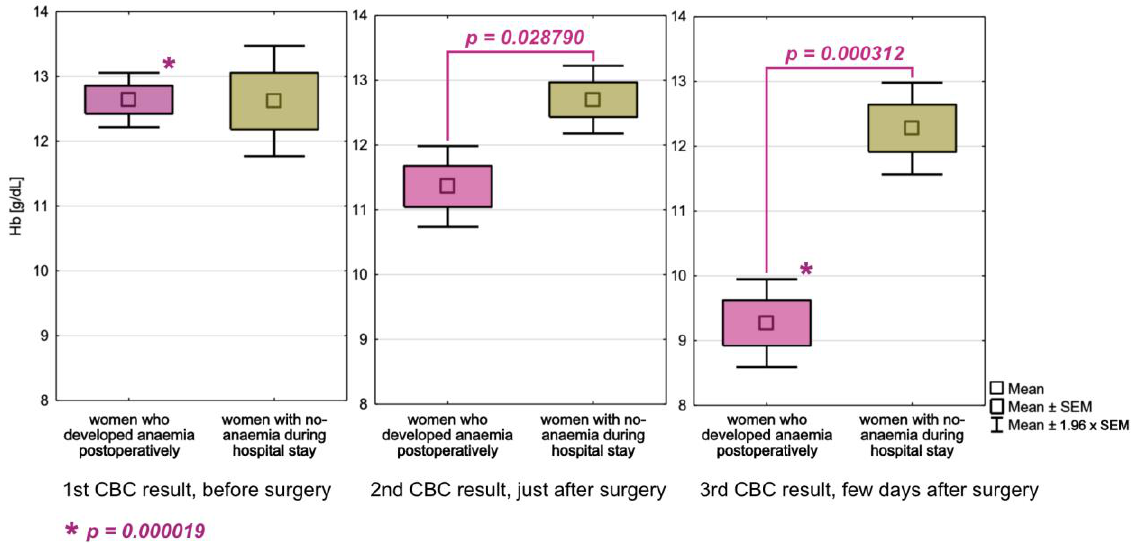
Figure 2. Dynamics of haemoglobin level changes in three consecutive complete blood count examinations in anaemia and non-anaemia women from a group of women with ≥ 3 complete blood counts. Table 4. Descriptive statistics of complete blood count parameters as well as hepcidin, IL-6, TNF- α , CRP, and SAA 1 levels in women with and without post-operative anaemia in the third complete blood count examination.